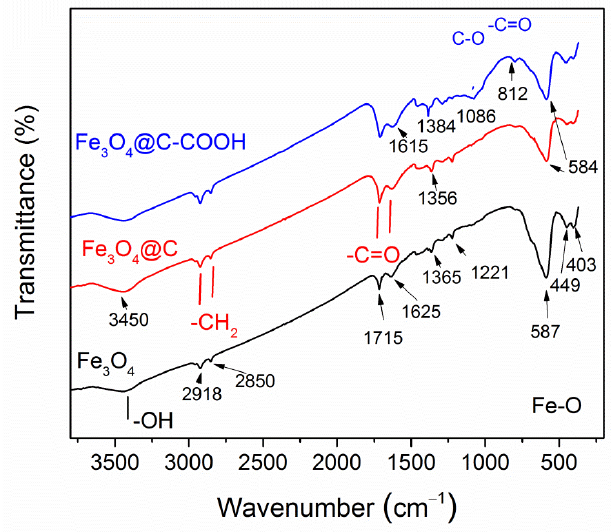
Figure 4. FT-IR spectra of synthesized Fe 3 O 4 , Fe 3 O 4 @C NPs, and Fe 3 O 4 @C NPs after nitric acid treat- ment.